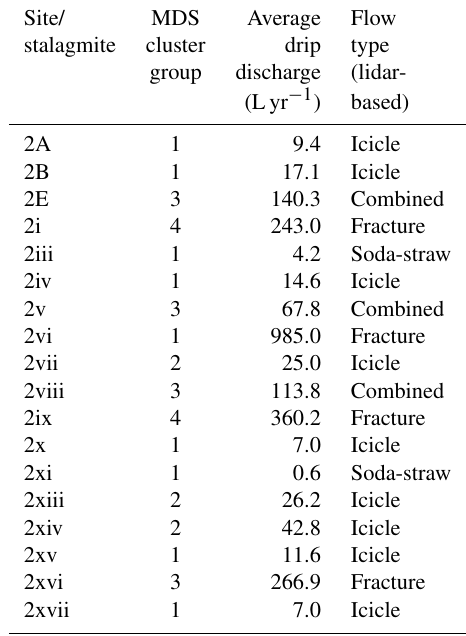
Table 2. MDS cluster groups with statistical properties of Cham- ber 2 drip